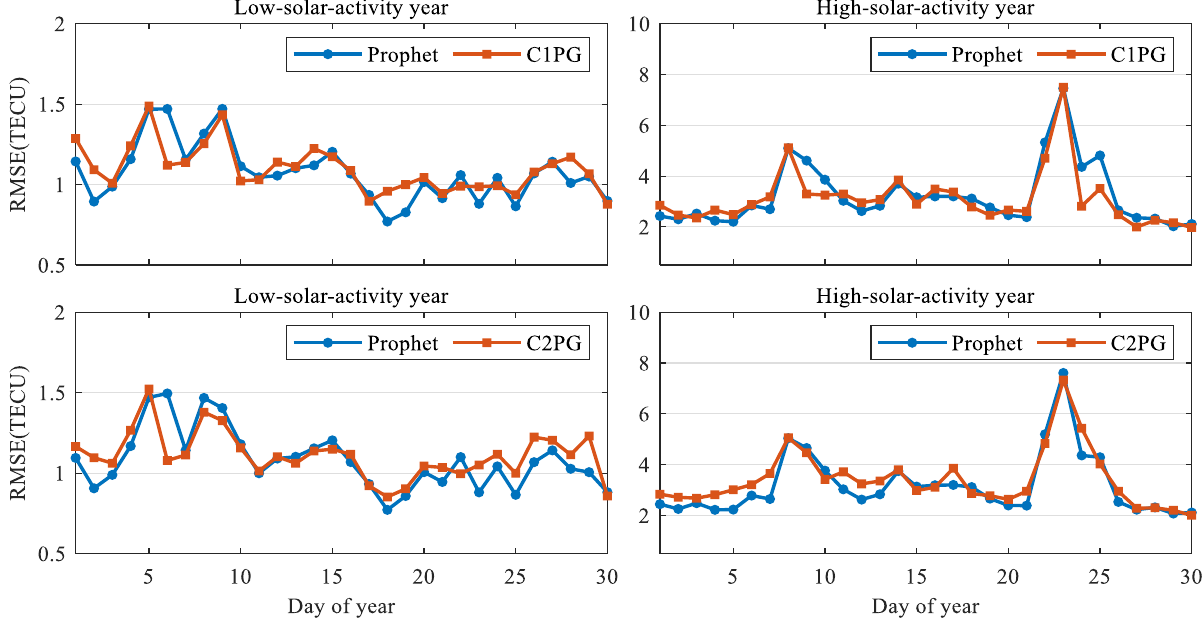
Figure 13. Daily RMSE statistics of the Prophet model and the COPG values, C1PG and C2PG refer to COPG values forecast for the first and second day. Blue represents the Prophet model, and orange represents the COPG value.